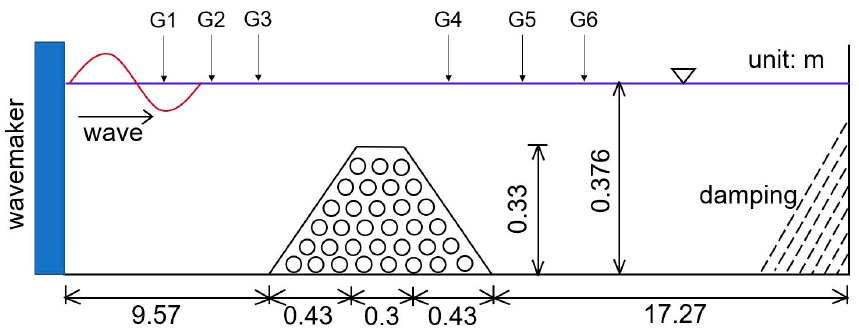
Figure 3. Computational layout for the regular waves transforming over the submerged permeable breakwater.